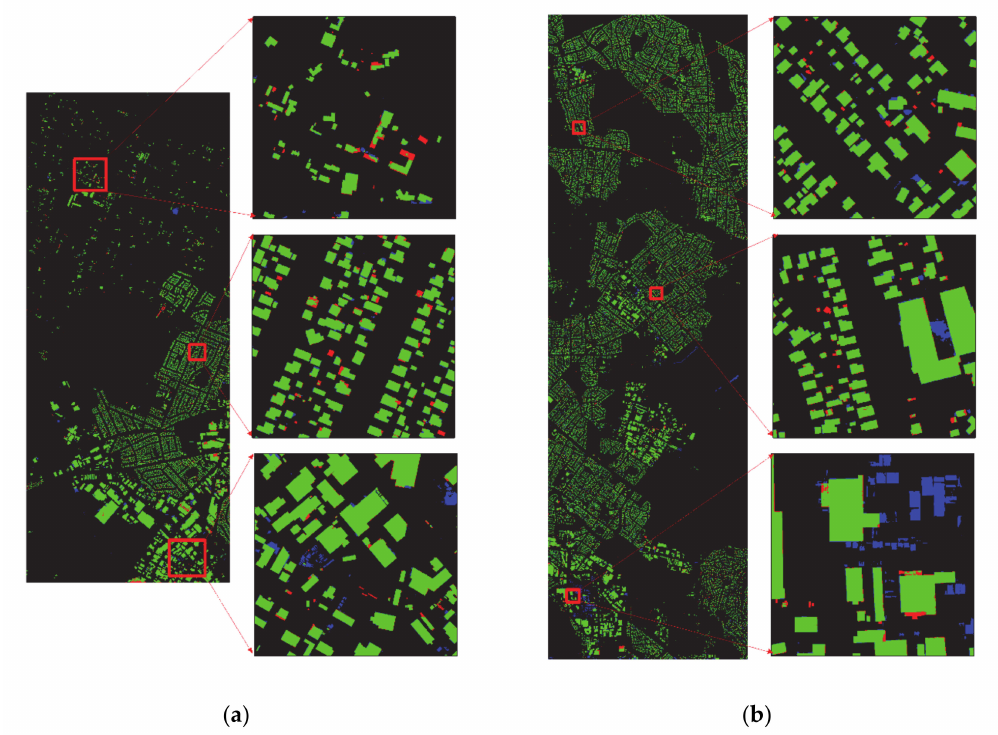
Figure A4. The performance of DR-Net with the dice coefficient loss and batch size set to 2 during training process, ( a , b ) show the building extraction result of the DR-Net on test A and test B area